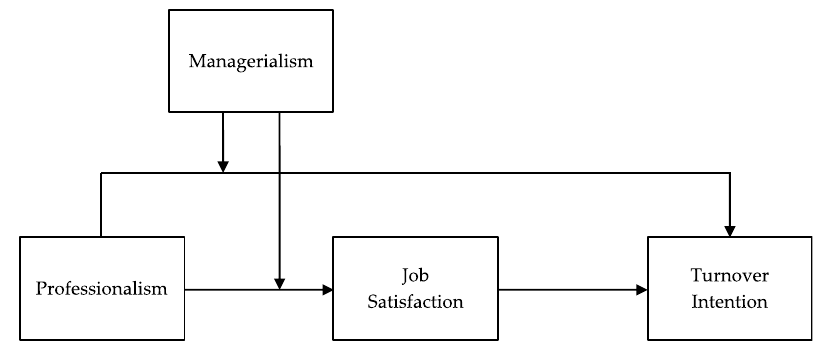
Figure 1. Hypothesized mediated moderation